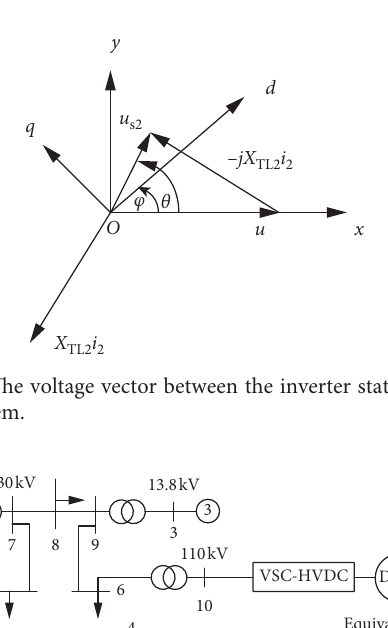
Figure 2: The voltage vector between the DFIG and the rectifier station.